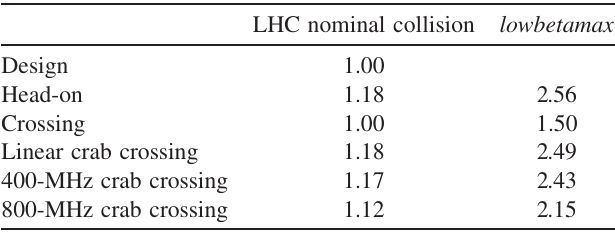
TABLE III. LHC luminosity ½ 10 34 cm (cid:1) 2 s (cid:1) 1 (cid:4) from GUINEA- PIG simulation, with local crabbing scheme for both